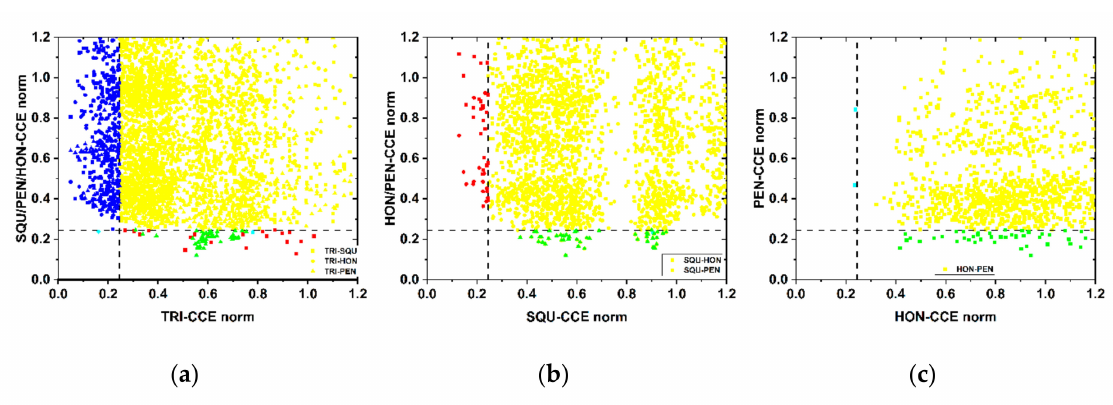
Figure 14. All possible combinations of parity plots X - vs. Y -CCE norm ( X (cid:44) Y ) from NVT simulations on a (2-D) thin-film system of 100-chains of N av = 12 at ϕ = 0.48 as seen in the right panel of Figure 11. ( a ) X = TRI and Y = SQU / PEN / HON; ( b ) X = SQU and Y = PEN / HON; ( c ) X = PEN and Y = HON; Vertical and horizontal dashed lines denote the CCE norm threshold below which a site is labeled as X - and Y -like, respectively. Blue, red, green, cyan and yellow colors correspond to TRI-, SQU-, PEN-, HON-, and amorphous (or unidentified) sites,